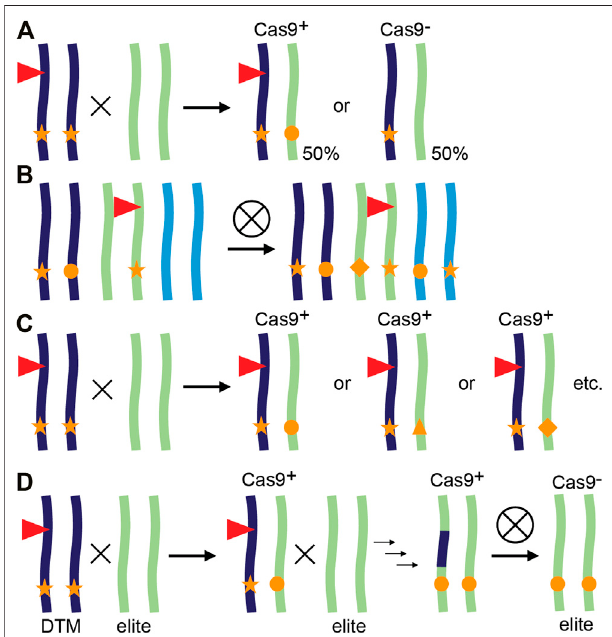
FIGURE 1 | Transgenerational gene editing and applications in plants. (A) Principle of transgenerational gene editing (TGE). A transgenic plant represented as a chromosome pair is hemizygous for a CRISPR/Cas9 containing T-DNA locus (red triangle) and edited in both alleles (stars). When crossed with a WT, the resulting progeny either lacks the T-DNA and inherits a single edited allele or inherits the T-DNA, resulting in (transgenerational) editing of the inherited WT allele. (B – D) Examples of TGE. (B) TGEforcontinuededitingofhomoeoallelesinwheat.Atransgeniclinemay have edits only in a subset of homoeoalleles at the homologous chromosomes. After self-crossing and selecting plants that inherited the T-DNA,allhomoeoallelesmaynowbeedited(Wangetal.,2018b). (C) TGEfor allelic variation. In tomato, a loss-of-function mutant (stars) also contains a CRISPR/Cas9 containing T-DNA targeting the promoter of the mutant gene. After a cross with WT, resulting T-DNA containing plants have one loss-of- function allele (star), and an allele with a promoter edit (other symbols). Every individual F1 plant has potentially a different promoter edit and phenotype as the phenotype is not determined by the inherited loss-of-function allele (Rodríguez-Leal et al., 2017). (D) Desired-target mutator (DTM) strategy. A maize plant hemizygous for a CRISPR/Cas9 containing T-DNA locus (red triangle) is crossed with an elite inbred line, resulting in TGE and editing of the elite allele. Additional rounds of TGE and backcrossing result in a new edited variety with no linkage drag (Li et al., 2017a).